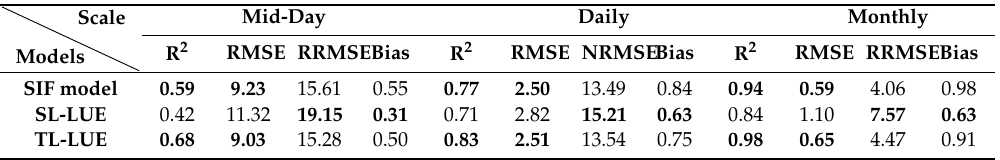
Figure 6. Validation of the SIF model, the SL-LUE model, and the TL-LUE model on the mid-day, daily, and monthly timescales in 2016, respectively. The panels ( a – c ): the seasonal variations of simulated and tower observed GPP. The panels ( d – f ): comparison of the GPP simulated by the SIF model (red lines), SL-LUE (green lines), and TL-LUE (blue lines). Table 4. R 2 , bias (observations minus simulations), root-mean-square error (RMSE), and relative / normalized RMSE (RRMSE) of the mid-day, daily, and monthly GPP (in gC m − 2 d − 1 ) in 2016 for the SIF model, SL-LUE model, and TL-LUE model, respectively. The units of bias and RMSE are both gC m − 2 d − 1 . The unit of relative RMSE is %.